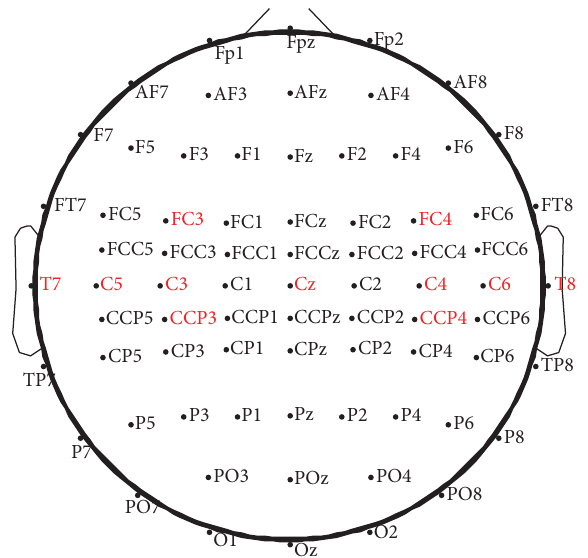
Figure 1: The positions of the chosen electrodes in the extended international 10–20